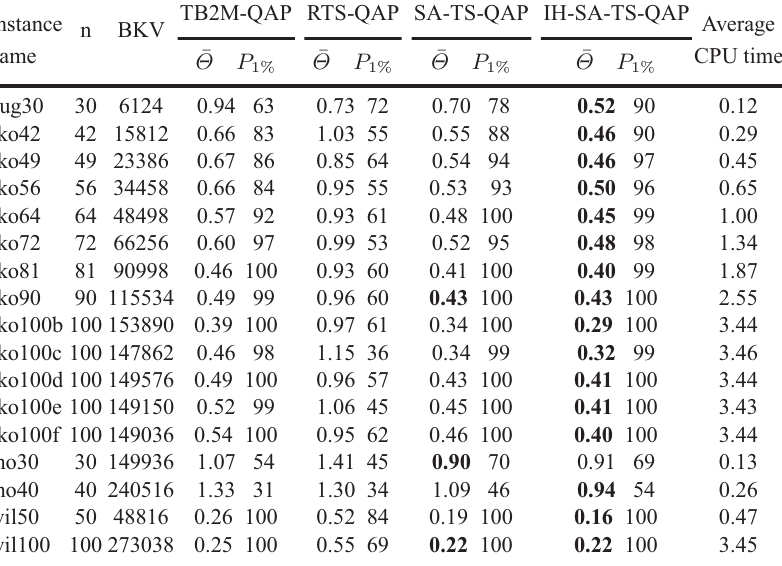
Table 1. Comparison of the algorithms for the QAP. The values of the average deviation ( ¯ Θ ), the percentage of 1% optimality ( P 1% ), and the CPU time (in seconds) are given. The values of the best average deviations are printed in bold